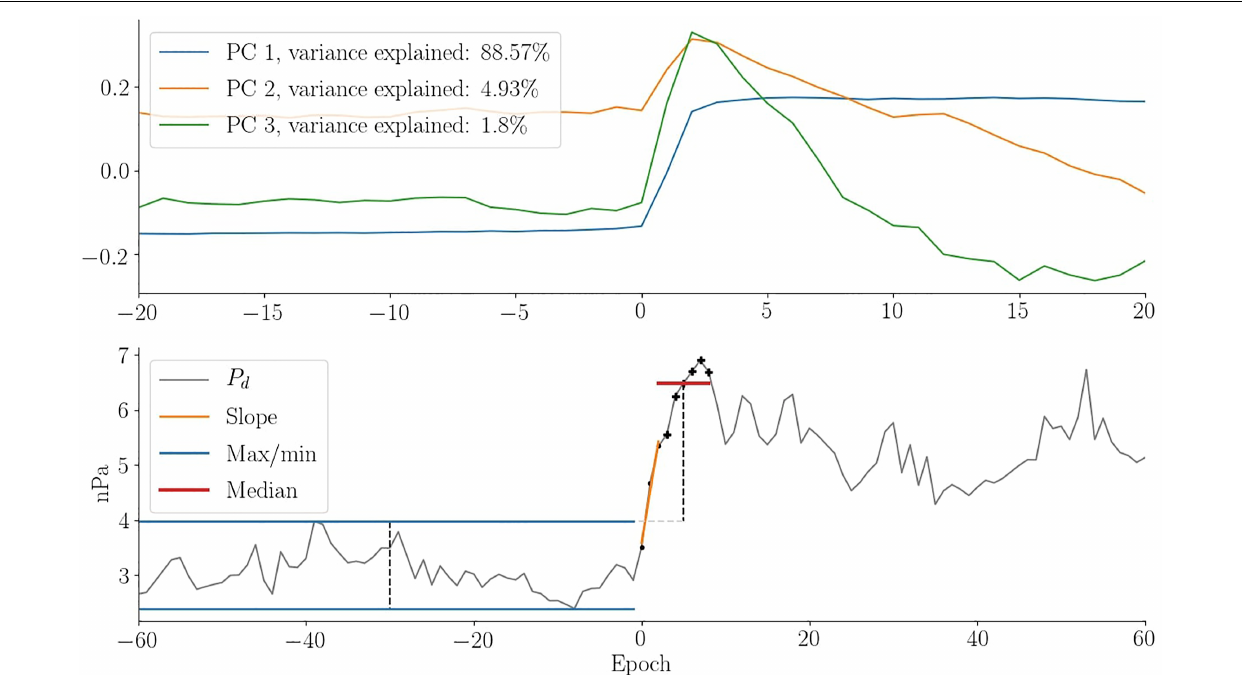
FIGURE 1 | Illustration of the features used in the random forest algorithm. The top panel shows the first three principal components as a result of a PCA analysis of the data used in events . The bottom panel shows the slope in orange, the minimum and maximum before onset in blue and the median after onset in red. The P d time series itself is an event observed May 8, 1998 at 09:20 by